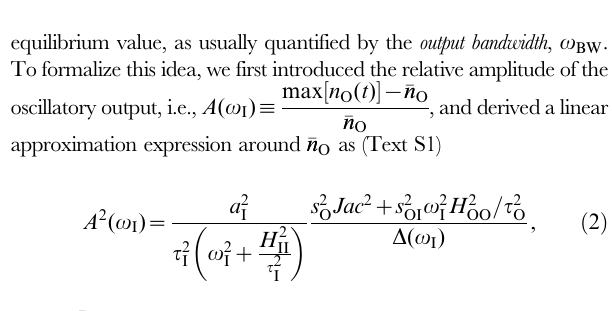
Figure 1. General scheme of signal detection by two-component modules. A. Illustration of the basic signal detection circuit studied. An input molecular species, I, acts as a biochemical signal on a minimal detection module (grey box) constituted by a sensor, S, and an output species, O. Lines indicate feasible interactions, either activation or inhibition, characterized by pairwise susceptibilities s ij (autoregulations were also considered but not depicted for the sake of clarity). B. Signal amplitude detection: A sudden change in input (step signal) produces an amplitude change in the output concentration n O determined by the total output susceptibility s O . (C) Signal frequency detection: An oscillatory input signal of frequency v I produces an oscillatory change in the output around the equilibrium value (cid:2) nn O , characterized by the relative amplitude A ( v I ) .